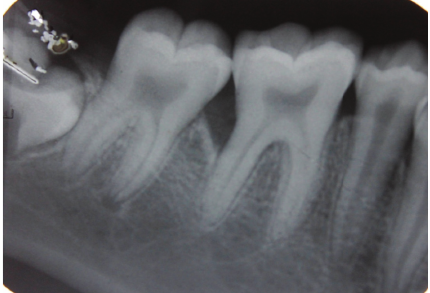
Figure 9: Intraoral periapical radiograph showing vertical bone loss in relation to